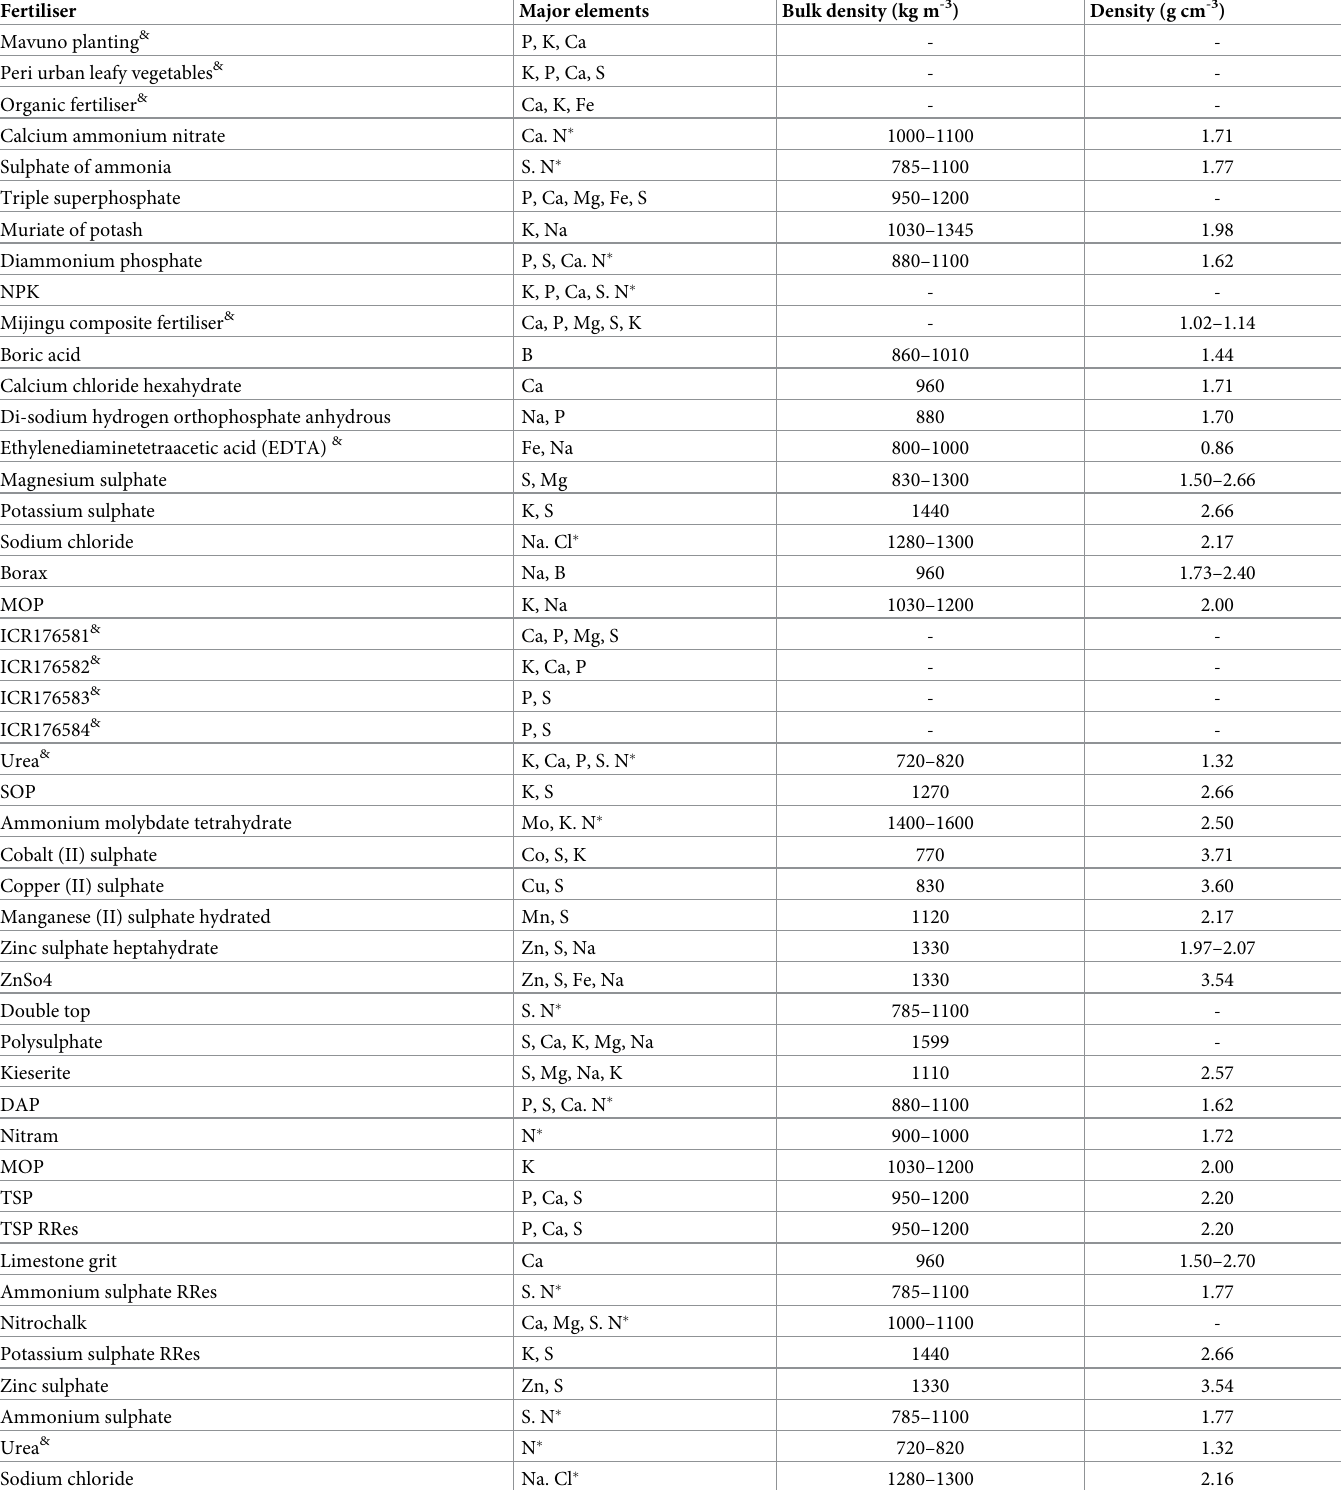
Table 1. Overview of fertilisers used for pXRF models calibration and